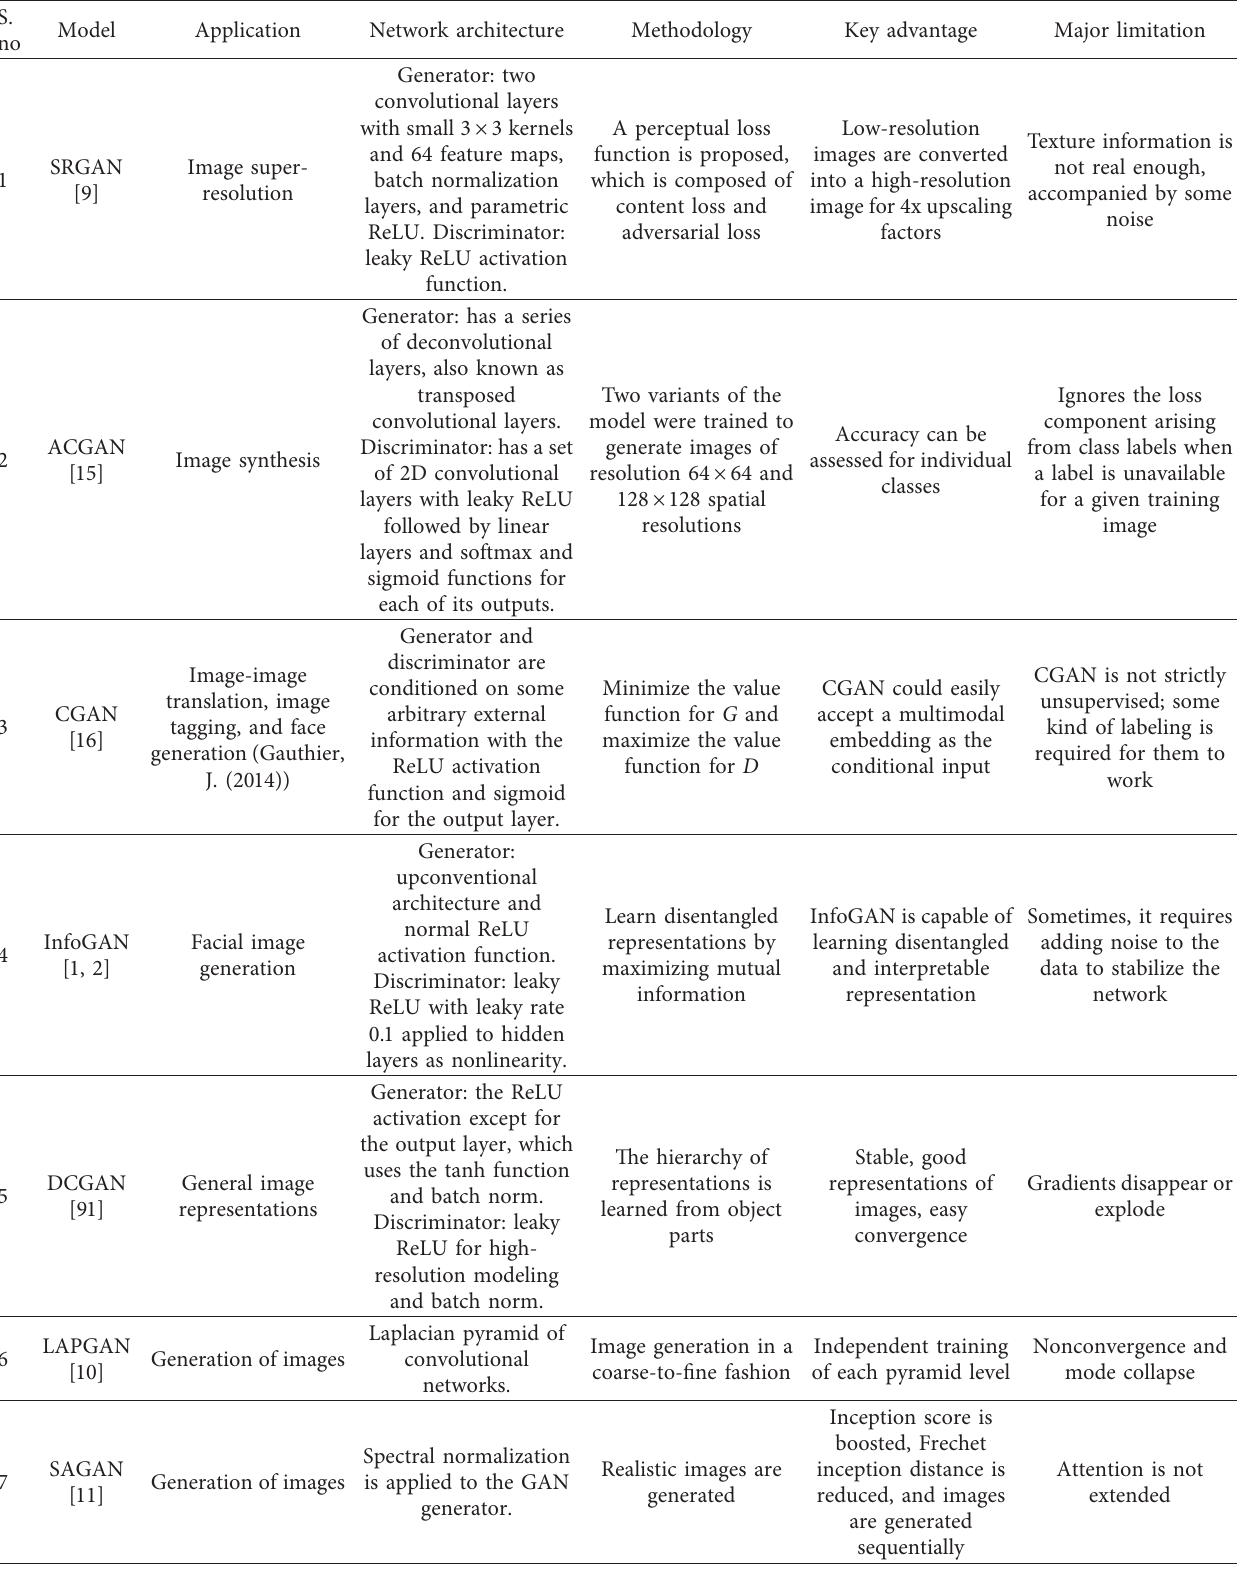
Table 5: Evolution of the deep